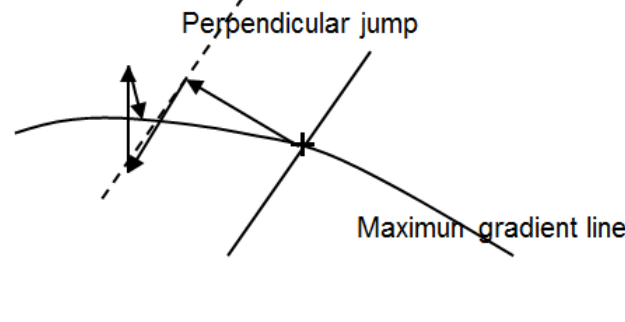
Figure 8. Convergence process towards a point of maximum